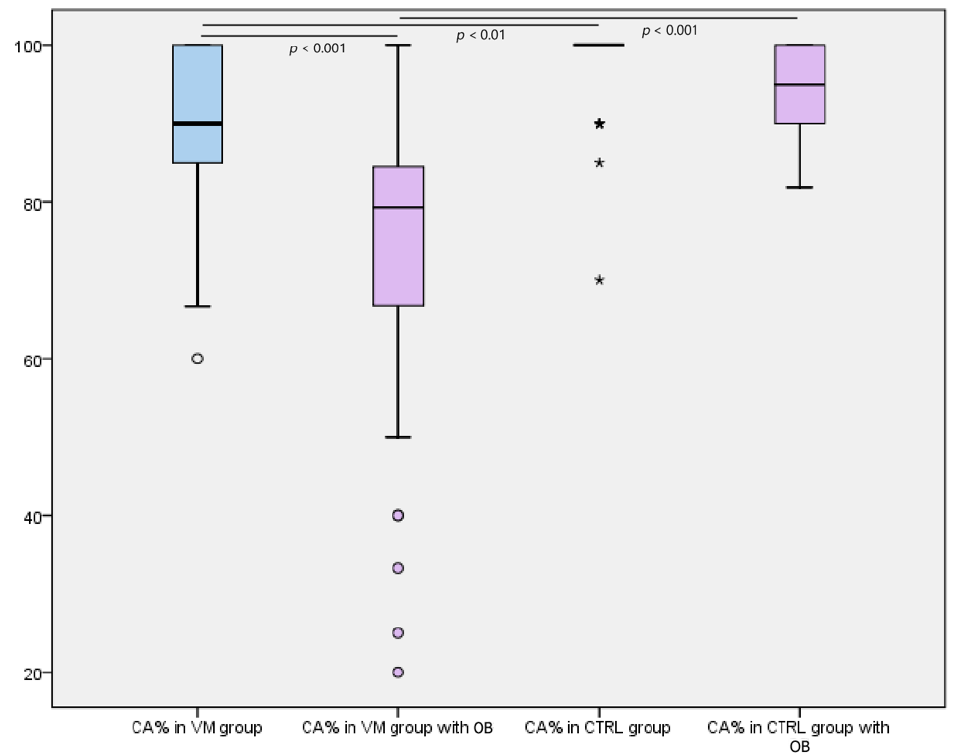
Figure 1. Boxplot showing the percentages of correct answers on the fHIT in the VM group and the CTRL group without and with optokinetic background (OB). A statistically significant difference was found between the %CA values of the VM group with and without OB ( p < 0.001), between the %CA values of the VM group without OB and the CTRL group without OB ( p < 0.01), and, most of all, between the %CA values of the VM group with OB and the CTRL group with OB ( p < 0.001). No significant difference was found between the %CA values of the CTRL group with and without OB. * = Extreme values outliers, considering a step of 1.5 × IQR (Interquartile range). The %CA values in the AUV-R group were 78.12% on the left and 39.81% on the right without OB; with OB, the %CA values were 72.23% on the left and 32.97% on the right. In the AUV-L group, the %CA values without OB were 53.60% on the left and 85.30% on the right; with OB, the %CA values were 40.25% on the left and 71.28% on the right. In the control group, the %CA values were 97.75% on the left and 97.5% on the right without OB and 94.71% on the left and 96.19% on the right with OB. No significant